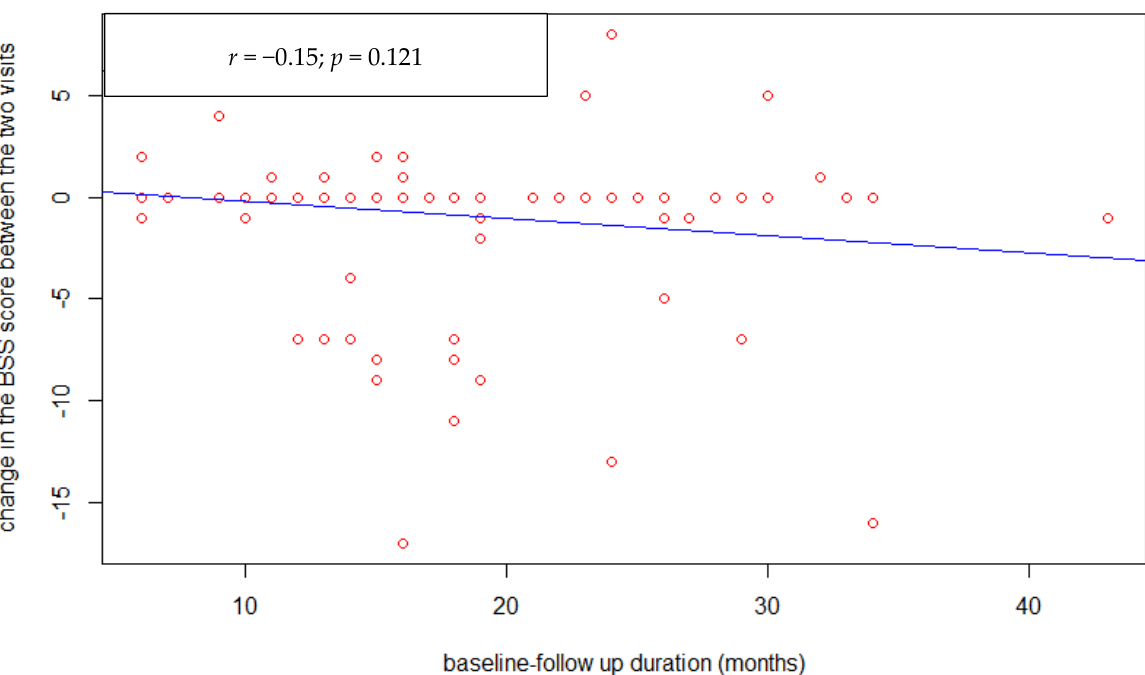
Figure 3. Correlation between the interval duration between the two visits and BSS change.